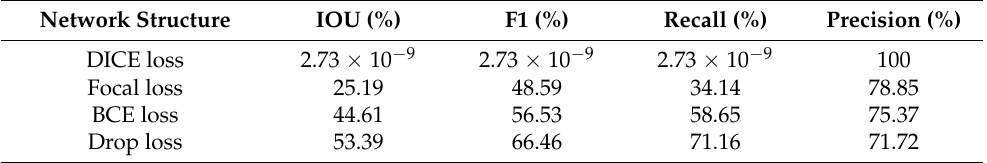
Table 3. Comparison among the Dice loss, Focal loss, and drop loss.